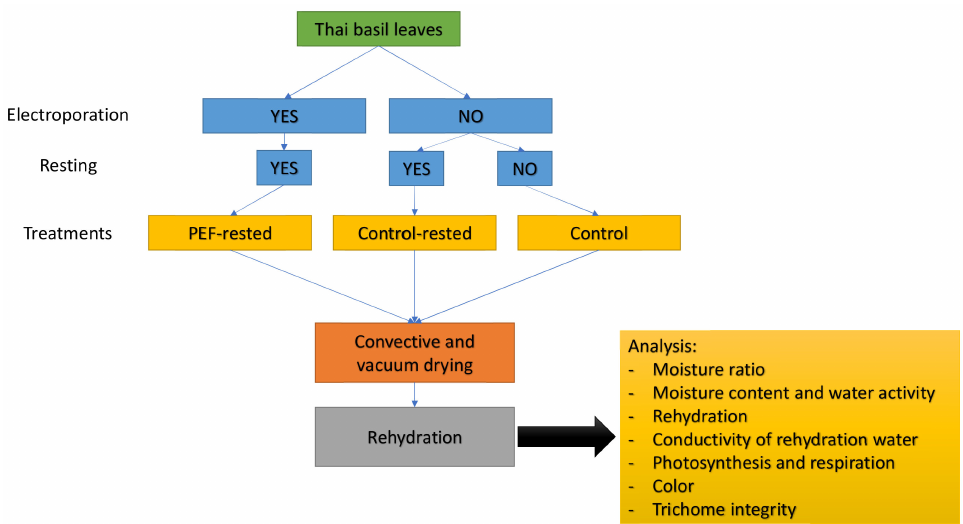
Figure 1. Diagram of treatments and analysis performed in this